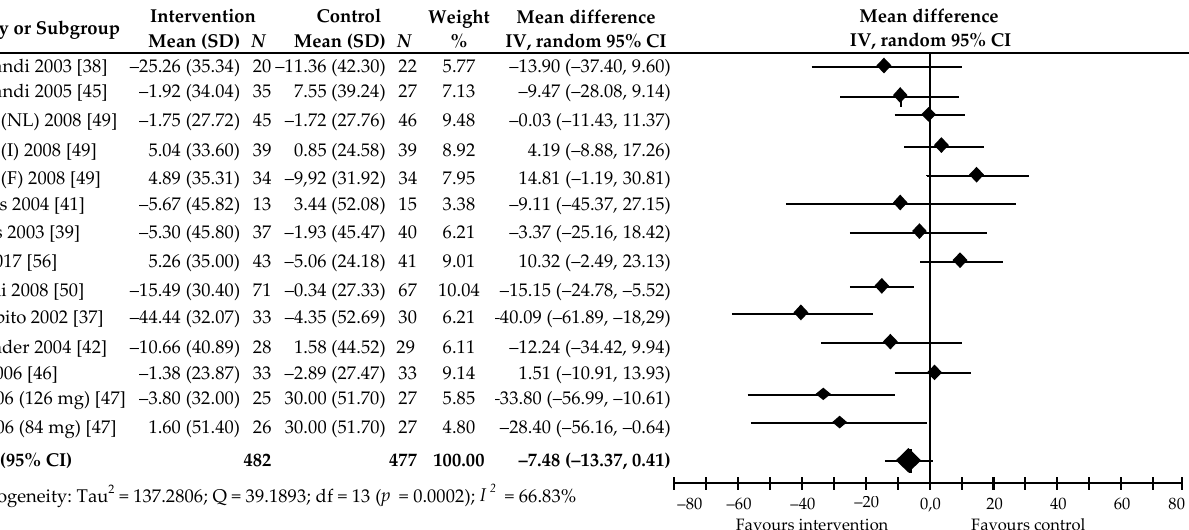
Figure 7. Percentage change in urine DPD values associated with intake of soy isoflavones compared with placebo. Note: in parentheses after the author’s name, Isof dose in studies with more than one treatment arm, or abbreviations of the names of the countries where the study was conducted (NL, the Netherlands; I, Italy; F, France), are shown; data calculated from the random-effects model are presented as weighted mean difference; IV, inverse variance; df, degrees of freedom; the horizontal lines denote the 95% CIs.